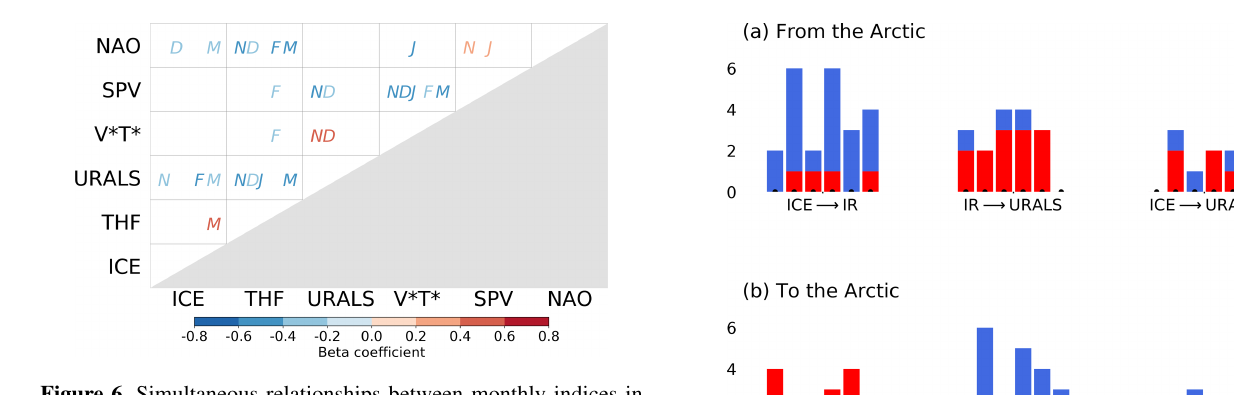
Figure 6. Simultaneous relationships between monthly indices in November (N), December (D), January (J), February (F), and March (M). Colours indicate the sign and strength of the relationship as given by the CEN beta coefficients (see Sect. 2.2).